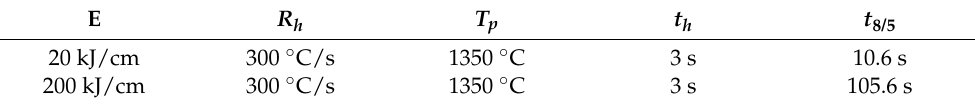
Table 2. Welding simulation parameters.